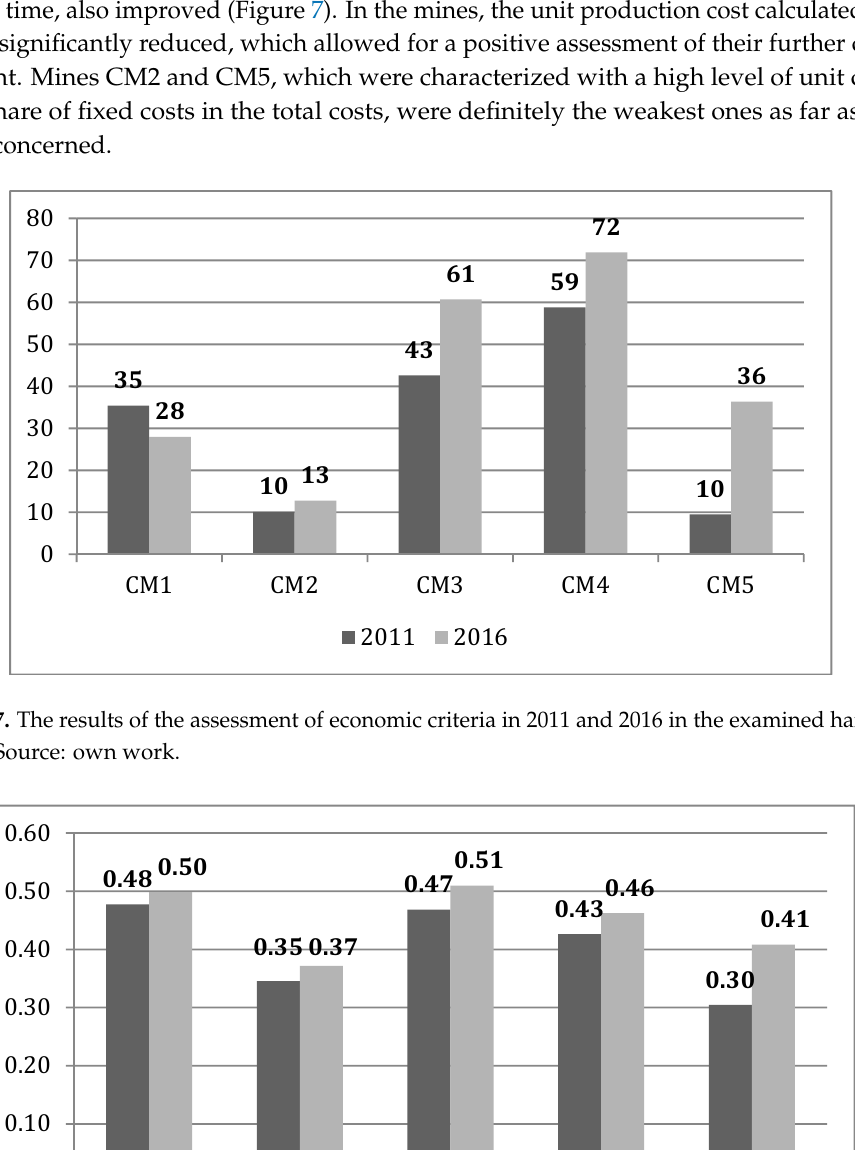
Figure 8. The results of the assessment of developmental possibilities in 2011 and 2016 in the examined hard coal mines. Source: own work.